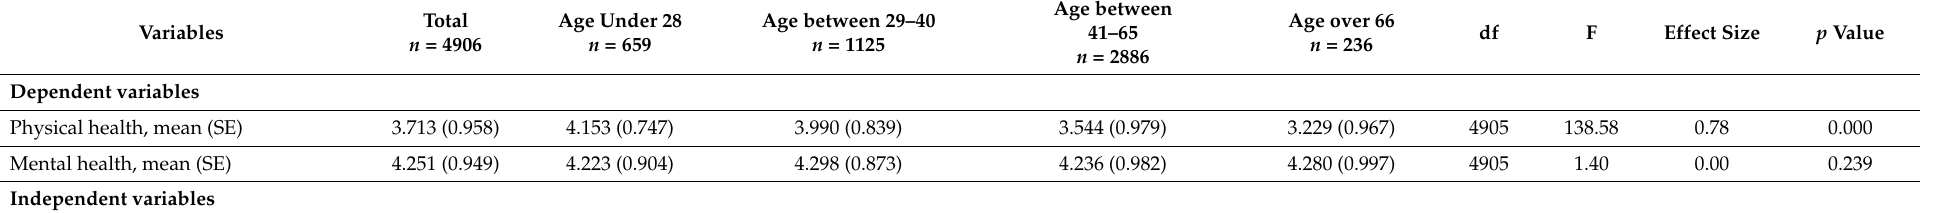
Table 1. Characteristics of 4906